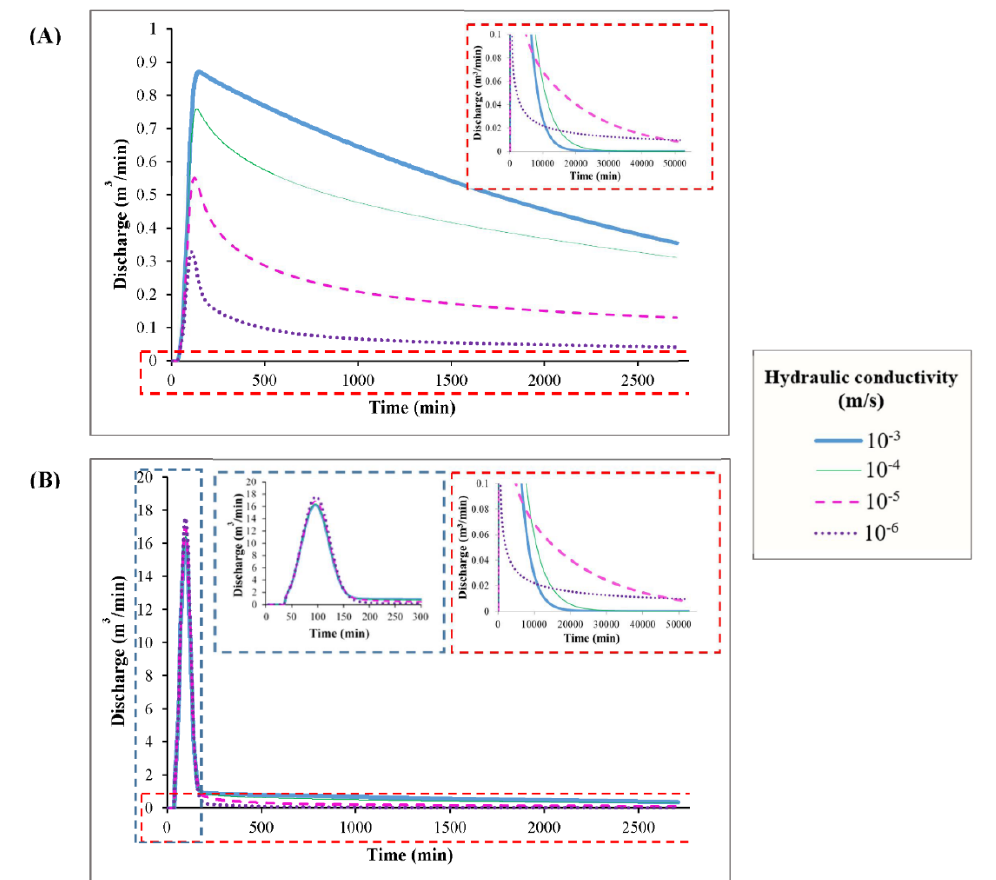
Figure 7. Spring hydrograph variability in relation to matrix hydraulic conductivity changes in scenarios A3 (Figure A ) and B3 (Figure B ).